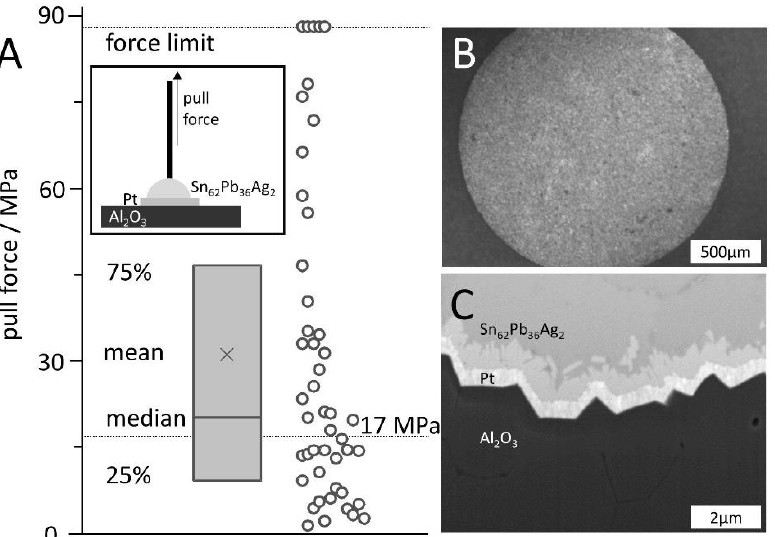
Figure 4. Pull test on FFF-printed ceramic-metal-pin sequences (see insert). ( A ) Pull force to destructive disjoin the pin and the ceramic. Box plot indicates 25–75% interval, the star marks the mean value, whereas the centerline is the median value. ( B ) Photo of a laser structured solder pad on aluminum oxide ceramics. ( C ) Electron microscope image of the cross-section of the layered composite of aluminum oxide ceramics (bottom), WTi10/platinum (500 nm), and the solder material (top). Between platinum and solder tin an intermetallic transition of about 0.75 µm was formed.